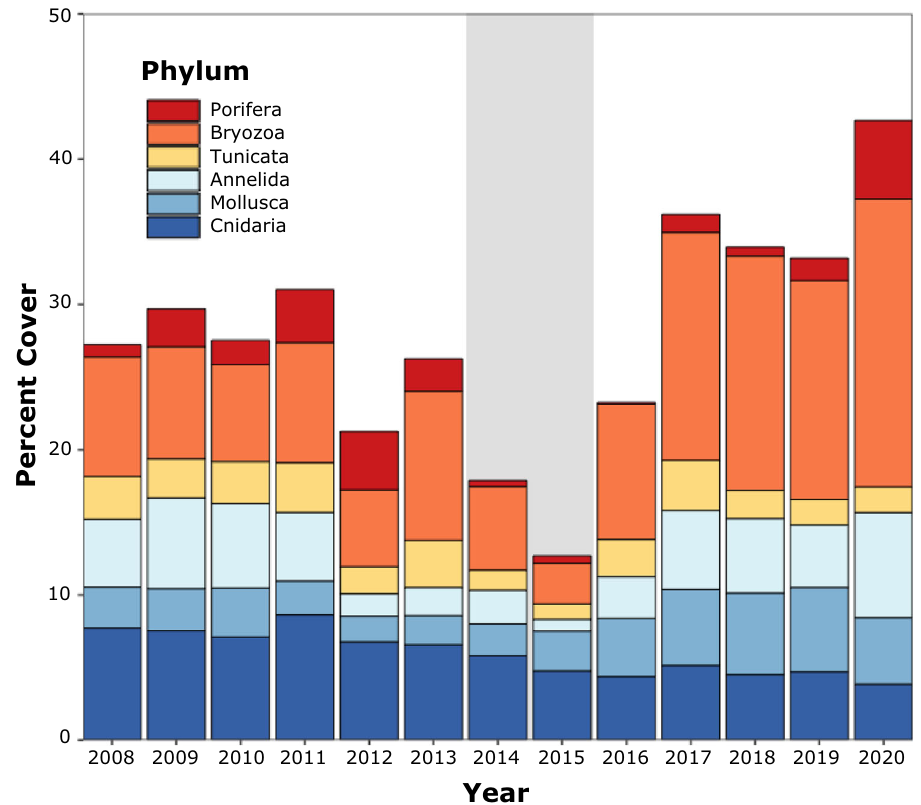
Fig. 3 Average annual percent cover of invertebrate phyla. Gray shading indicates the Blob period of 2014 – 2015 when bryozoan, ascidian, sponge (Porifera) and annelid cover declined